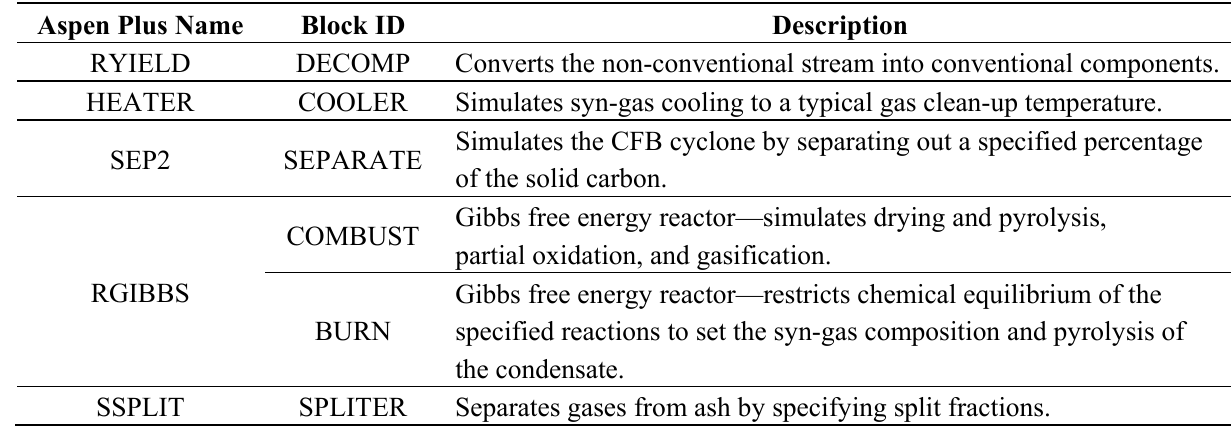
Table 4. Description of Aspen Plus flowsheet unit operation